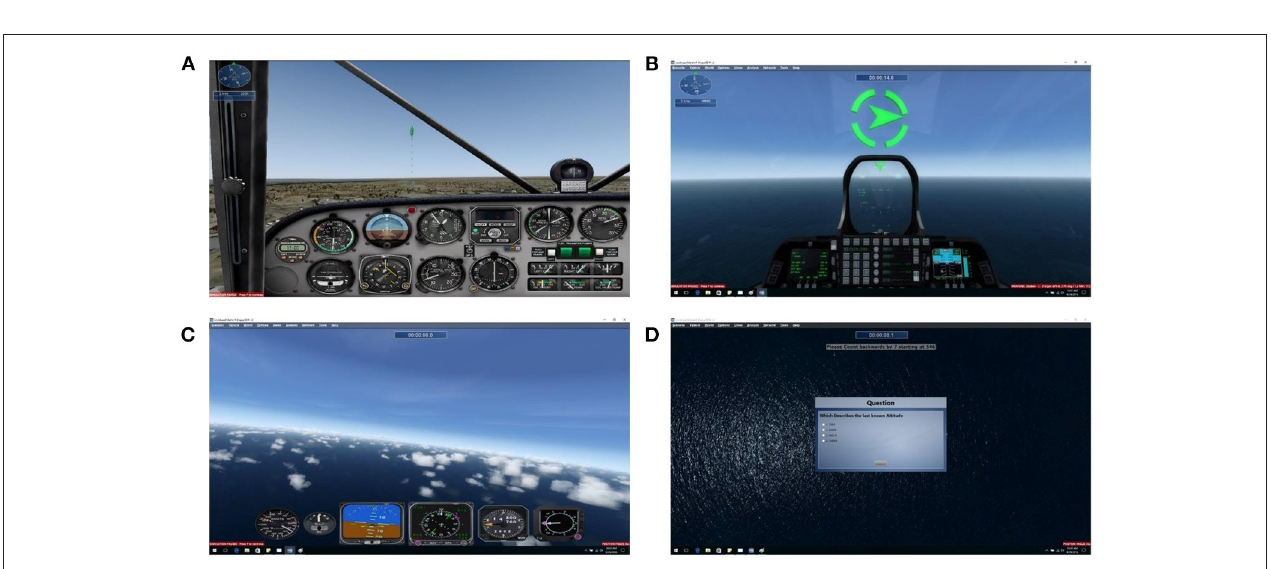
FIGURE 2 | Sample screens displaying the three tasks used. (A) Landing task viewpoint. (B) Rings task viewpoint. (C) Situation awareness task video. (D) Situation awareness task question screen.